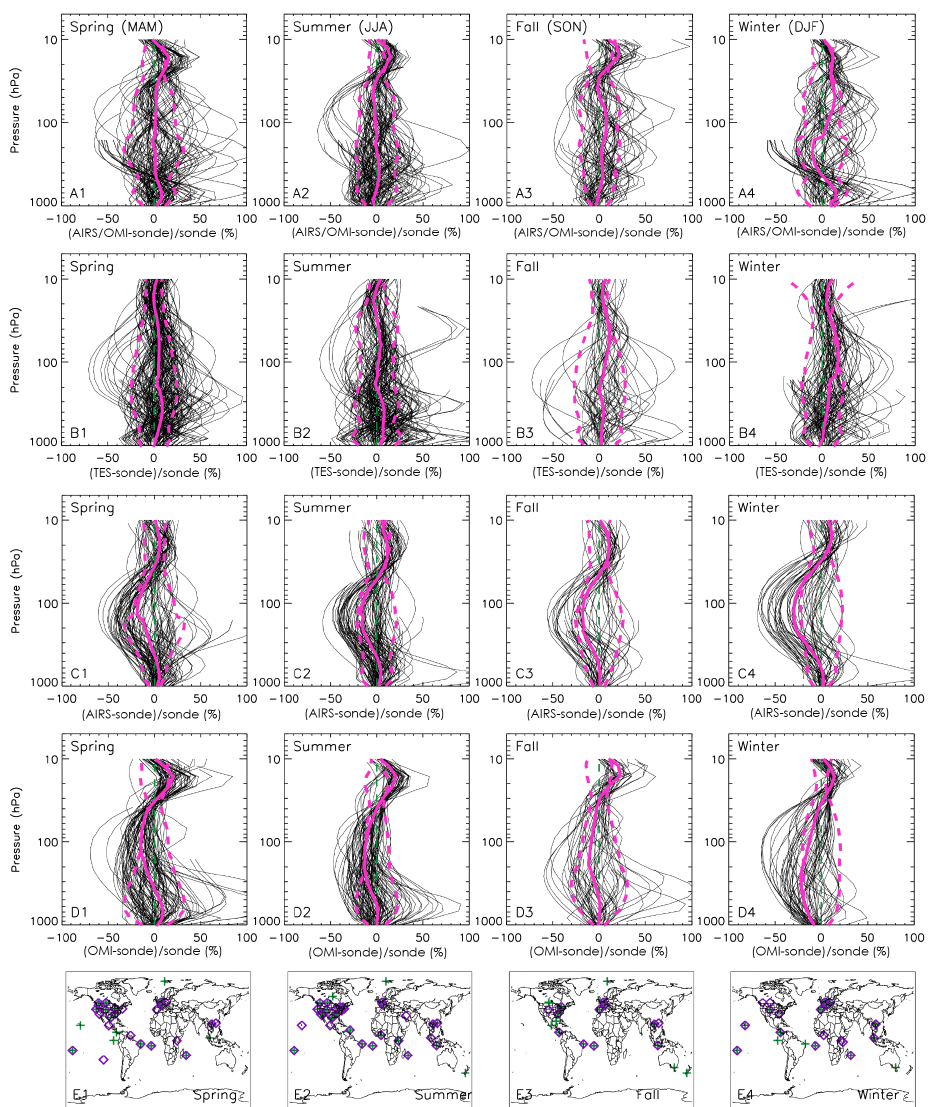
Figure 6. Joint AIRS + OMI–sonde (A1–A4) , TES–sonde (B1–B4) , AIRS–sonde (C1–C4) , and OMI–sonde (D1–D4) percentage differences of measured ozone concentration for the four seasons (months abbreviated in parentheses) on a global scale. Individual profiles are shown in black, and the mean and 1 σ standard deviation range are overlaid in solid magenta (mean) and as dashed magenta lines. The profiles were plotted after removing cloudy scenes and flagged satellite (joint AIRS + OMI and TES) data. (A1–A4) Joint AIRS + OMI vs. ozonesonde; (B1–B4) TES data (version 6) vs. ozonesonde; (C1–C4) WOUDC sonde location that have coincident measurements with joint AIRS + OMI (green plus signs) and TES (purple